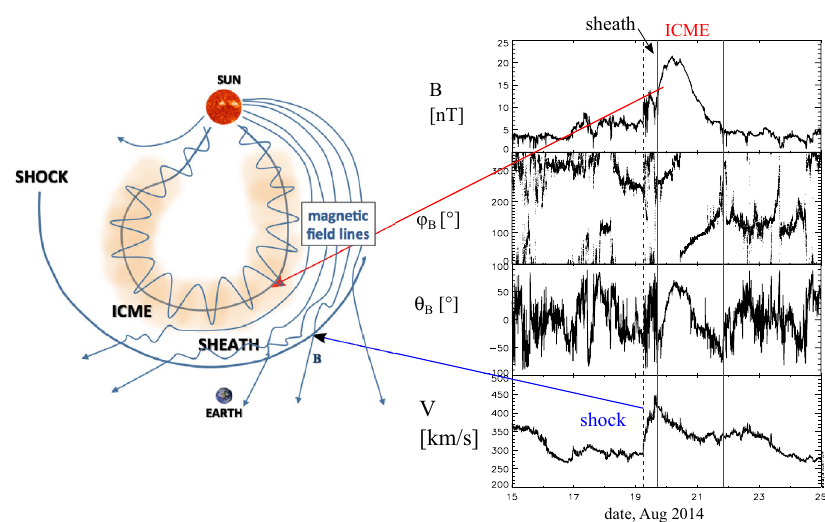
Fig. 1 (Left) A schematic of an ICME showing also the leading fast forward shock (arc), and the sheath region. The ICME shown here is depicted to have a flux rope structure, not always detected in-situ. (Right) Solar wind observations during an ICME from the ACE spacecraft located at the Lagrangian point L1. The panels show from top to bottom: the magnetic field magnitude, the longitude and latitude angles